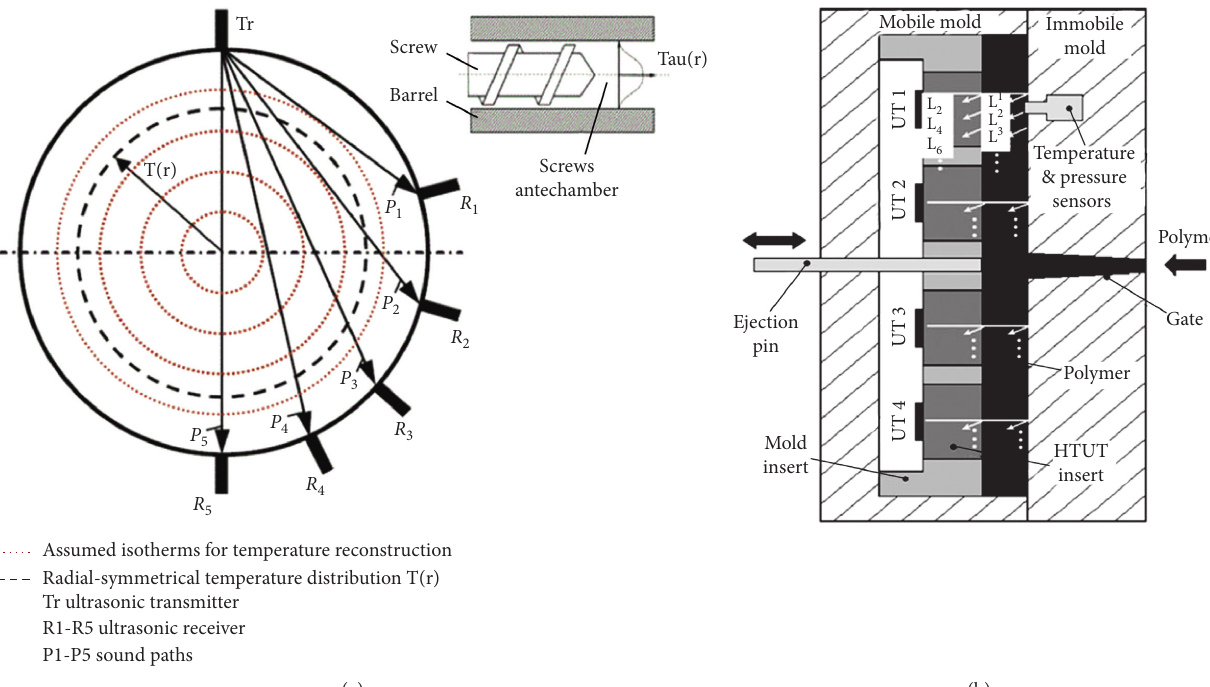
Figure 4: (a) Positions of the ultrasound transducers and resulting sound paths through the concentric ring segments used in ultrasound tomography [43]. (b) A cross-sectional view of an in-mold detection system